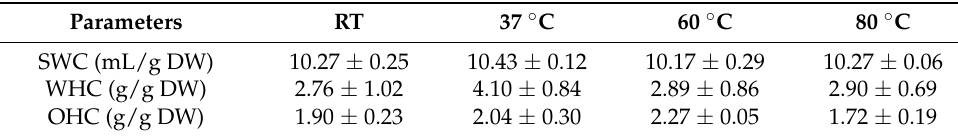
Table 8. The SWC, WHC and OHC of S. polycystum at various